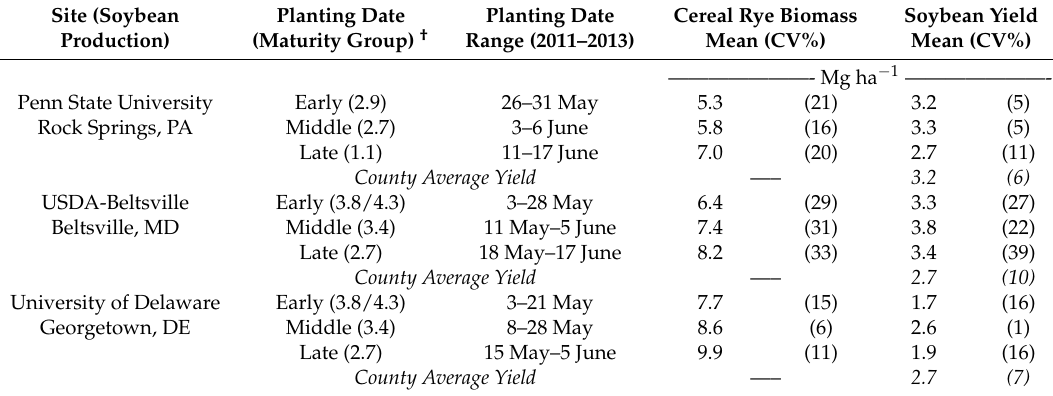
Table 1. Cereal rye biomass and soybean yields in an organic cover crop-based rotational no-till experiment (2011–2013) conducted by Penn State University, the USDA Agricultural Research Service (ARS) Sustainable Agricultural Systems Laboratory in Beltsville, MD and University of Delaware. Cereal rye biomass and soybean yields are averaged across high-residue cultivation treatments ( n = 2), blocks ( n = 4) and years ( n = 3; 2011–2013) for the three planting date treatments (early, middle, late) evaluated in the experiment. The coefficient of variation (CV) is reported to describe inter-annual yield variability (2011–2013) among alternative planting date strategies and county-level average conventional